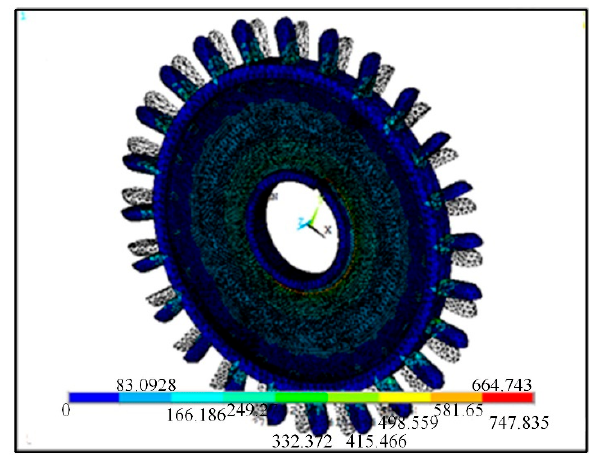
11 of 20 Figure 12. Orthographic views of the venturi (unit: mm). Figure 13. Dimensioned drawing of the water wheel (unit: mm) . 3. Simulation Analysis of Key Parts of the Sensor 3.1. Finite Element Stress Analysis of the Sensor Hydraulic Structure